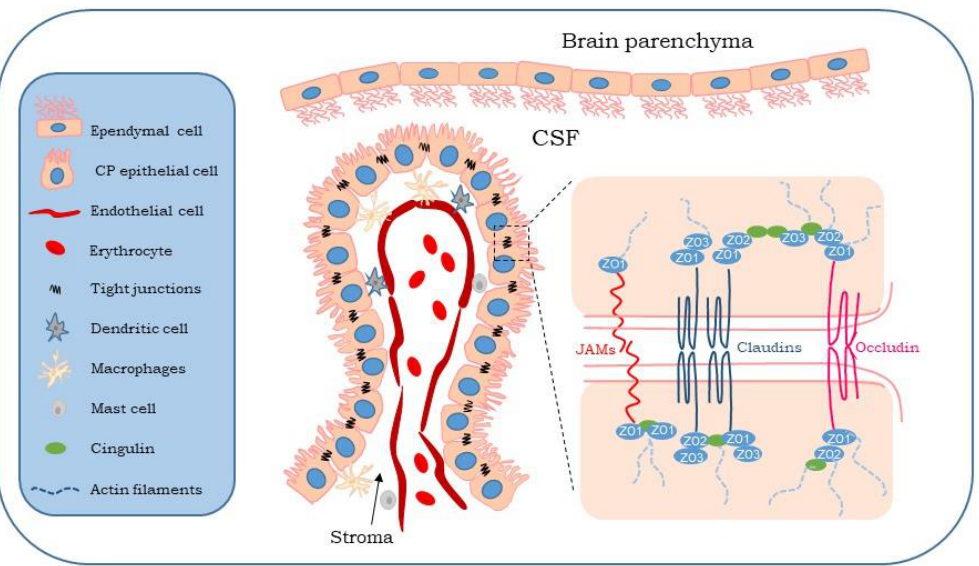
Figure 1. Illustration of choroid plexus epithelial cells ( left ) and tight junctions at the luminal mem- brane ( right ). CP: choroid plexus; CSF: cerebrospinal fluid; JAMs: junctional adhesion molecules; ZO: zonula occludens.